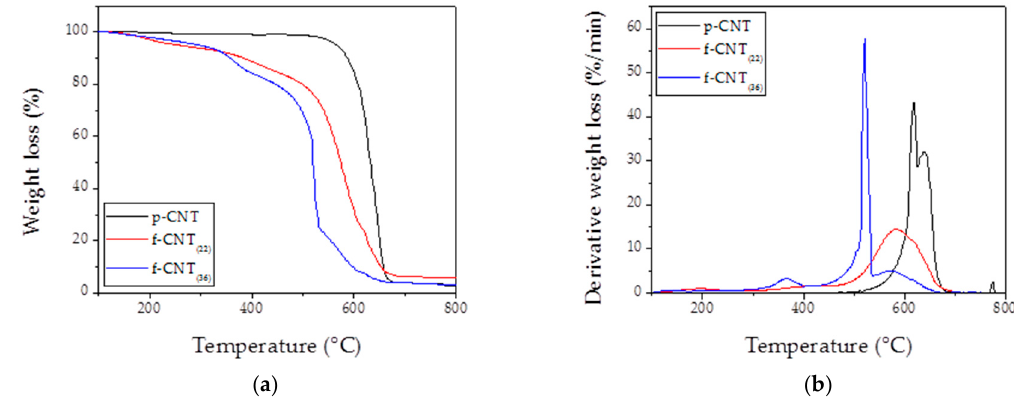
Figure 3. TG (thermogravimetry) ( a ) and DTG (derivative thermogravimetry) ( b ) analysis on used carbon nanotubes fillers.